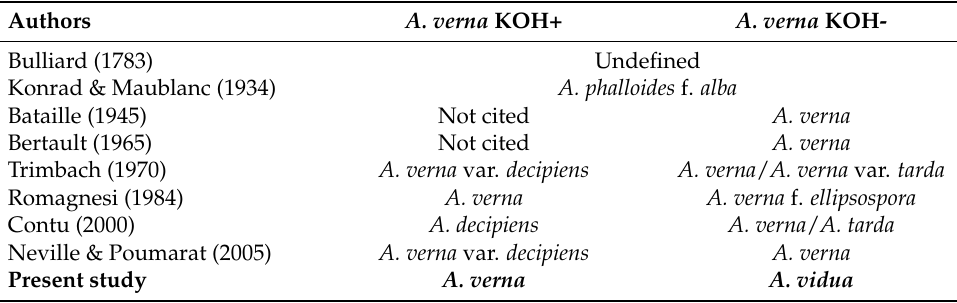
Table 1. Main interpretations of Amanita verna in